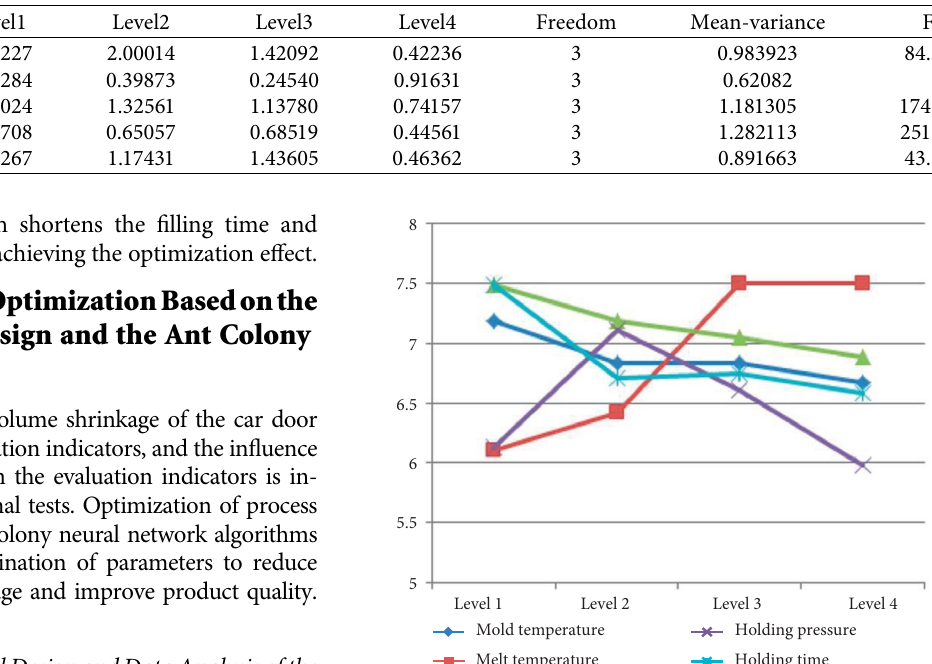
Table 8: Analysis of variance of warpage deformation.